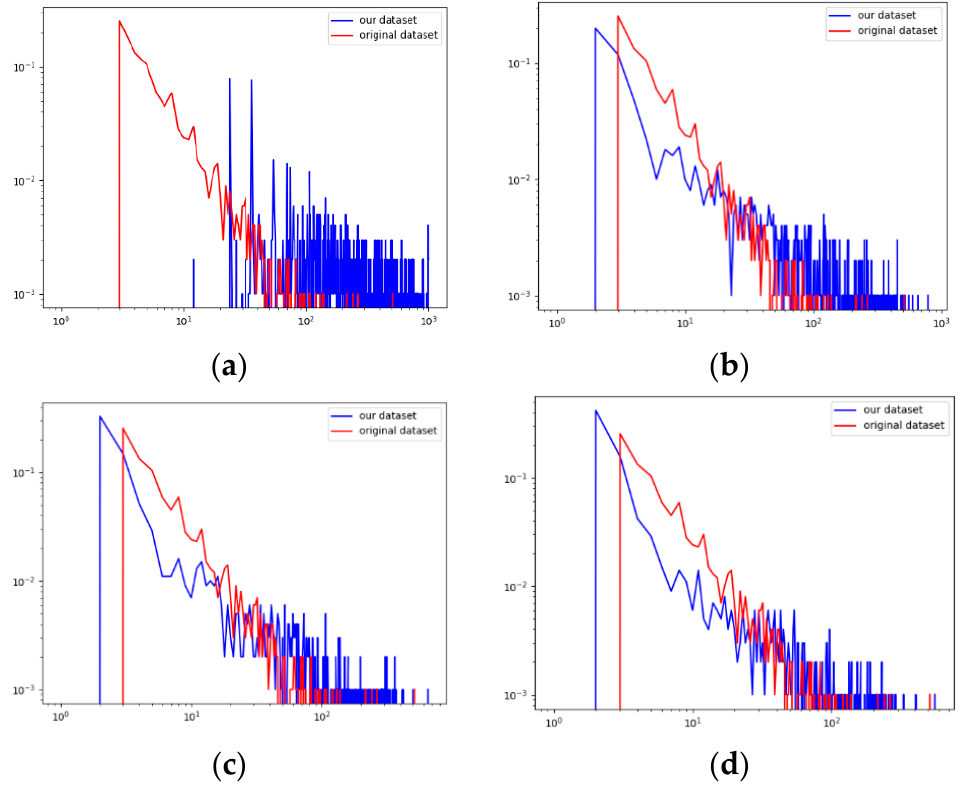
Table 1. Different values of 𝜏 1 and 𝜏 2 .